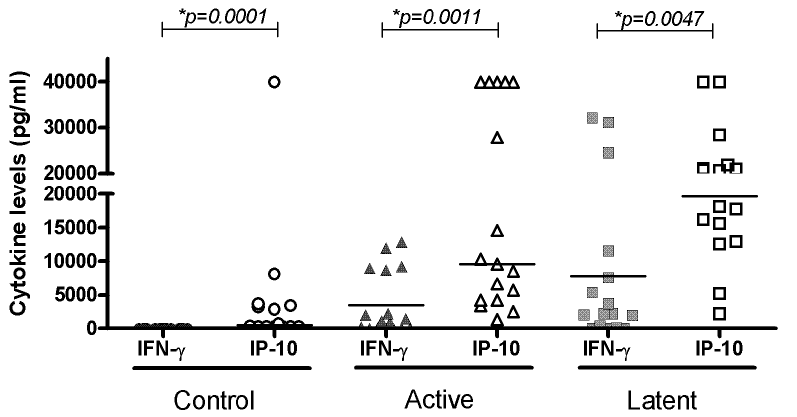
Figure 2. IFN- c and IP-10 levels (pg/ml) in Antigen stimulated samples of patients with active and latent TB and a control group. Horizontal lines indicate median values. Controls are represented by # , active TB by n , and LTBI by % . Open symbols represent IP-10, closed symbols represent IFN c samples.